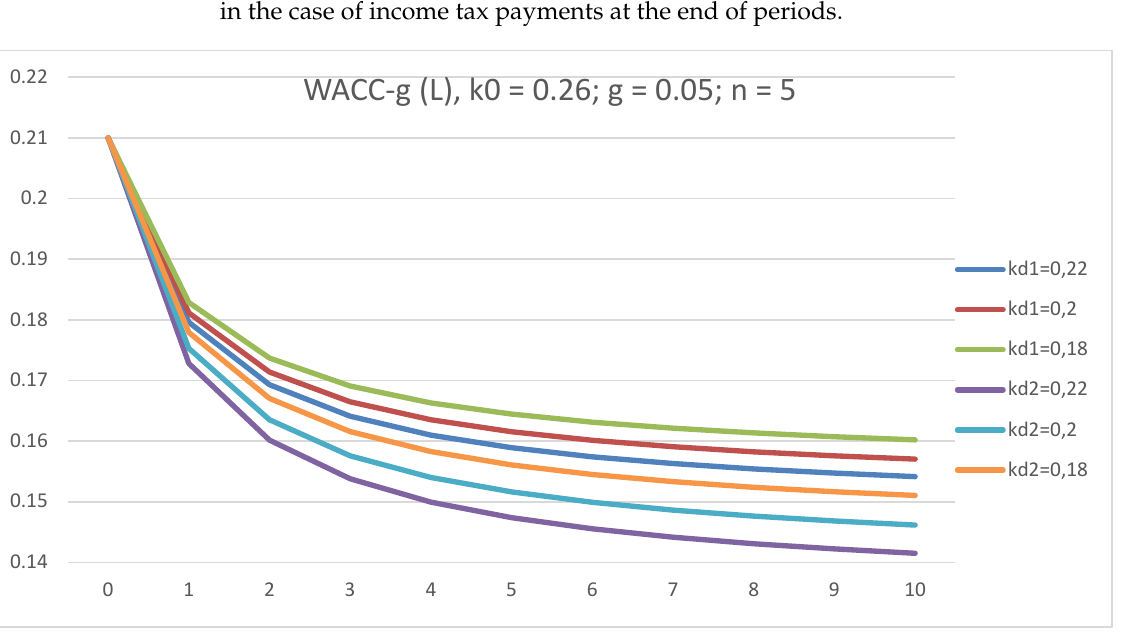
0.2; 0.18; t = 0.2; g = 0.05, for a five-year